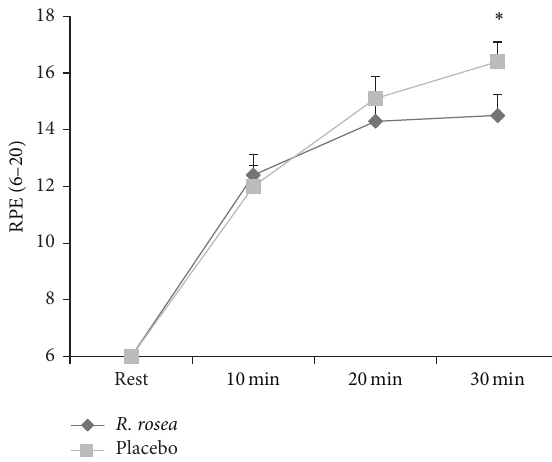
Figure 1: Mean ± SE of RPE (6–20) at rest and during 30 min submaximal cycling between R. rosea and placebo conditions ( ∗ 𝑃 = 0.003